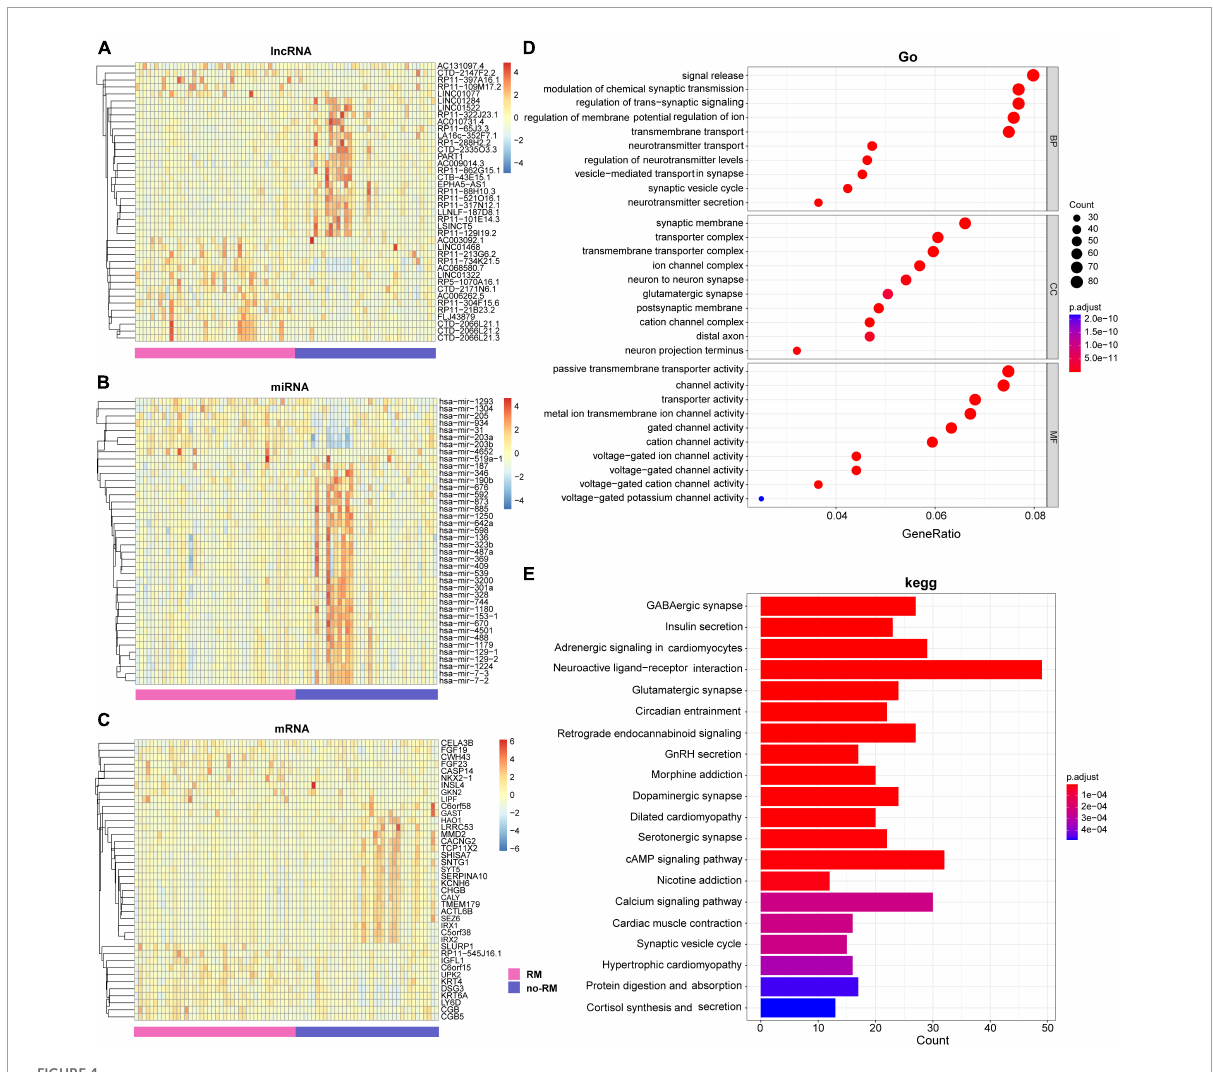
FIGURE4 Difference analysis and enrichment analysis of different omics between two groups. The heat map of the DEGs of (A) lncRNA; (B) miRNA; (C) mRNA between the RM and no-RM group, the x -axis is the sample of two groups, and the y -axis is the top 40 expressions with significant differences screened by DEseq2. (D) GO analysis of DEGs between RM and no-RM. (E) KEGG analysis of the DEGs between RM and no-RM, the X -axis is the ratio of differentially expressed genes enriched in the corresponding pathway, and the Y -axis is the name of the pathway;